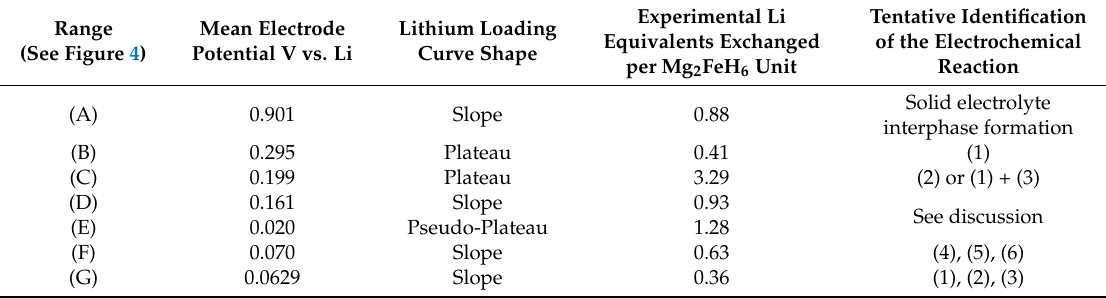
Table 3. Composition of samples cycled at various temperatures, calculated from the pressure composition isotherms reported in Figure